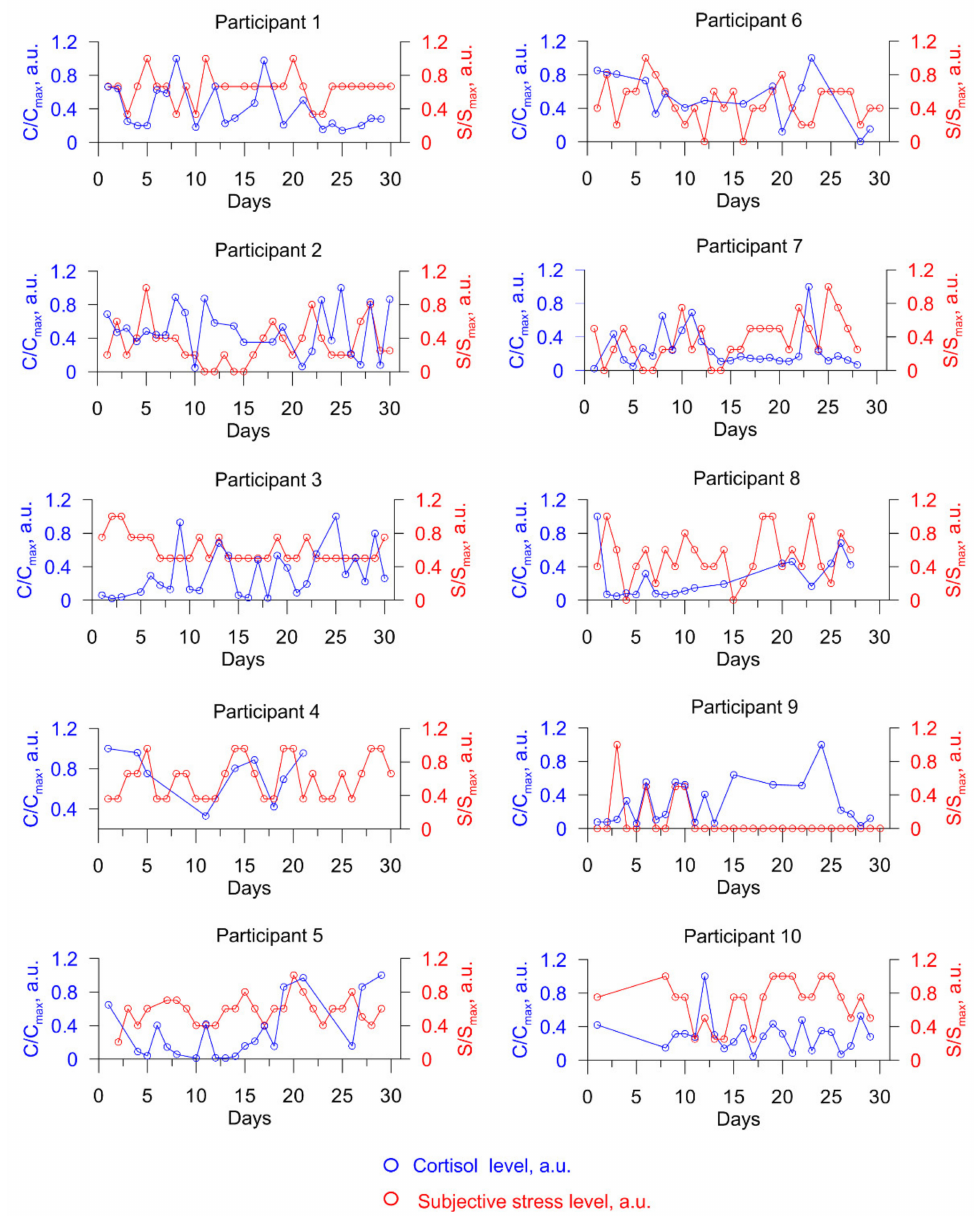
Figure 6. Profiles of changes in stress of each of the participants during the month. Blue denotes “cortisol” stress values expressed in C/C max , where C is the current value of the concentration of cortisol for each study participant, ng/mL; C max is the maximum value of the concentration of cortisol in saliva for the study period for each participant, ng/mL. Red denotes emotional stress valuesexpressed in S/S max , where S is the current value of the emotional stress for each study participant, a.u.; S max is the maximum value of the emotional stress for the study period for each participant,